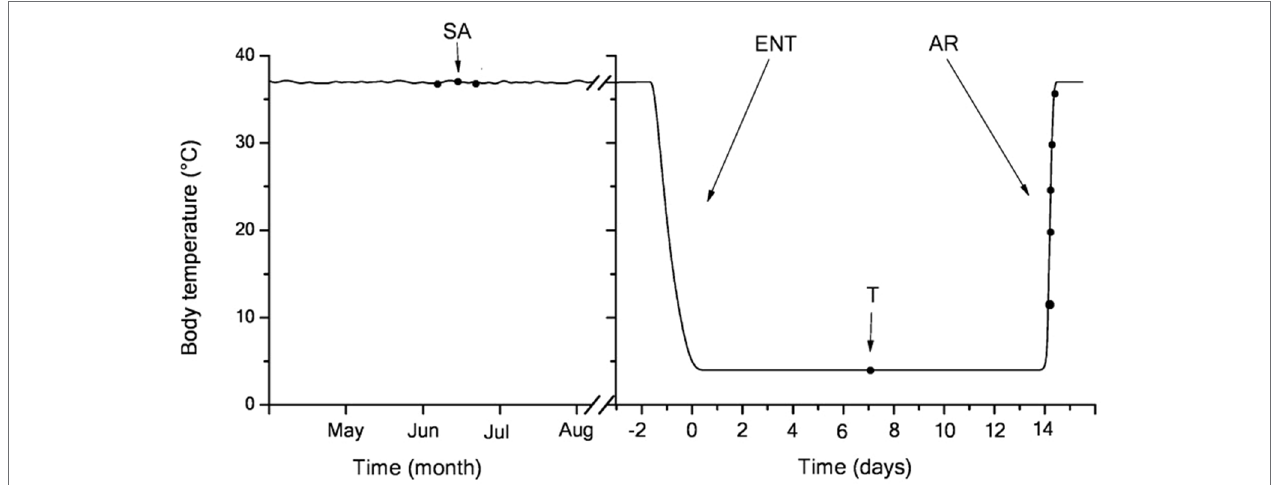
FIGURE 1 | Body temperature dynamics in the hibernating little ground squirrels (LGS; y -axis) vs. the month of the year (left; three-letter code; starting from May) and days of a single bout at the end of January (right; x -axis). Blood samples were retrieved at seven time points (black dots) coinciding with summer activity (left) or hibernation (right): in mid-torpor and during arousal (Tb 4–37 ° C). After entering torpor, Tb slowly decreased from euthermic (36 ± 1 ° C) to near-ambient temperature (3.5–4.5 ° C). During 2-week torpor, Tb was maintained within 3.8 ± 1 ° C. Body temperature in summer active and torpid animals was measured every day, upon entering torpor − every hour, during arousal − continuously. During arousal, animals rapidly rewarm to euthermic Tb levels. SA, summer active; ENT, entry to torpor; T, mid-torpor; and AR,